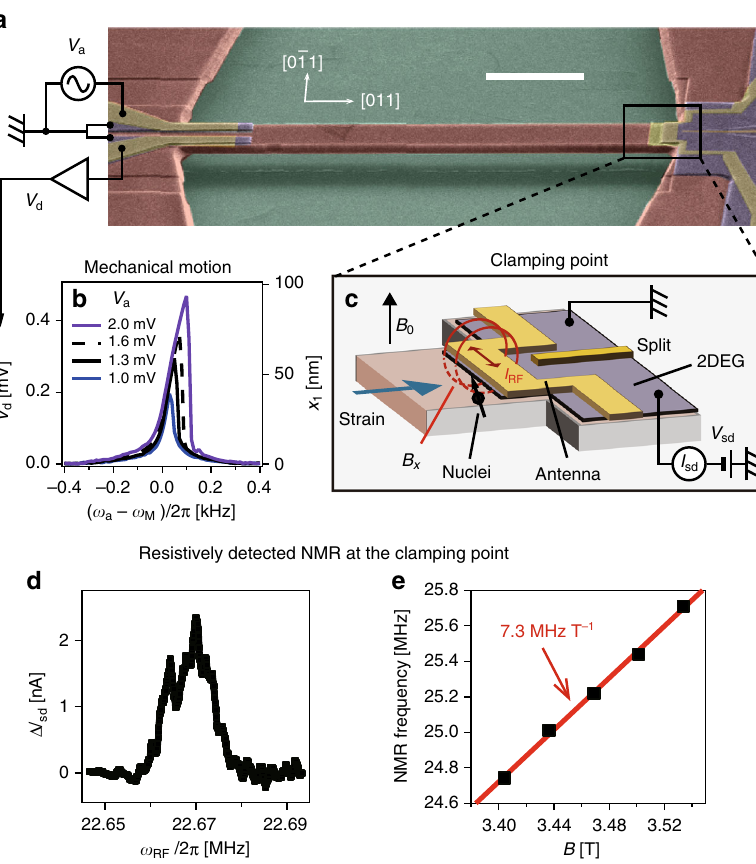
Fig. 1 Experimental setup. a False-color scanning electron microscope image of the device (scale bar, 10 μ m). A GaAs-based doubly clamped electromechanical resonator is suspended from the substrate. Two Schottky gate electrodes are de fi ned on the left clamping point in order to piezoelectrically actuate and detect the mechanical motion. b Frequency response of the mechanical resonator with different actuation voltage V a plotted as a function of actuation frequency ω a /2 π with ω M /2 π = 1.716 MHz. The right axis shows the calibrated mechanical amplitude x 1 at the center of the beam. c A schematic of the device structure at the clamping point, where the maximum strain can be induced from the fundamental fl exural mode of this resonator. A static magnetic fi eld B 0 is applied perpendicular to the 2DEG, while a transverse magnetic fi eld B x is irradiated to the nuclei underneath the antena gate to which an RF current I RF with a frequency ω RF is also applied. d A plot of Δ I sd ( ≡ I sd − I 0 with I 0 being the offset current) at B 0 = 3.1 T measured as a function of ω RF without mechanical actuation. e A plot of the NMR peak frequency as a function of B 0 , showing linear B 0 -dependence, from which a gyromagnetic ratio of 7.3 MHz T − 1 for As 75 is